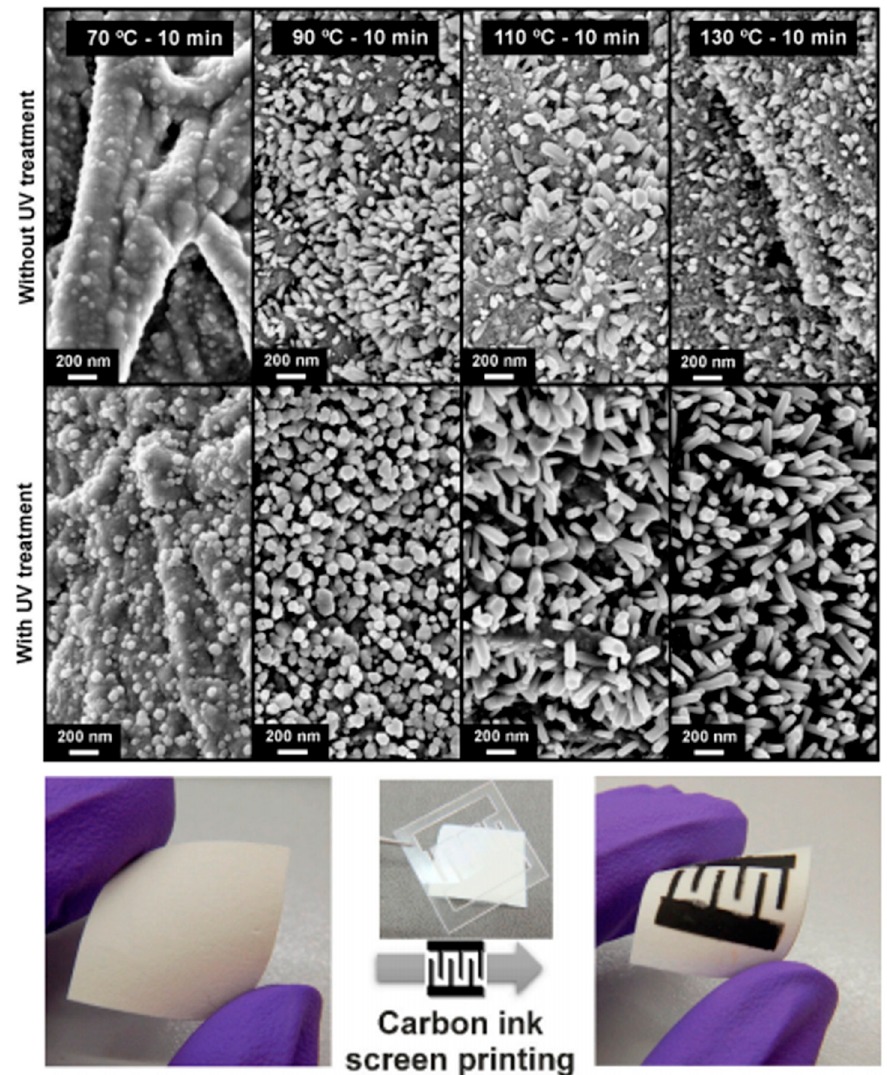
Figure 12. SEM images of the ZnO nanorods grown on Whatman paper with different temperatures in microwave synthesis. The effect of UV treatment has been investigated. The real image of the paper-based UV sensor is presented [11]. Reproduced with permission of MDPI [11].